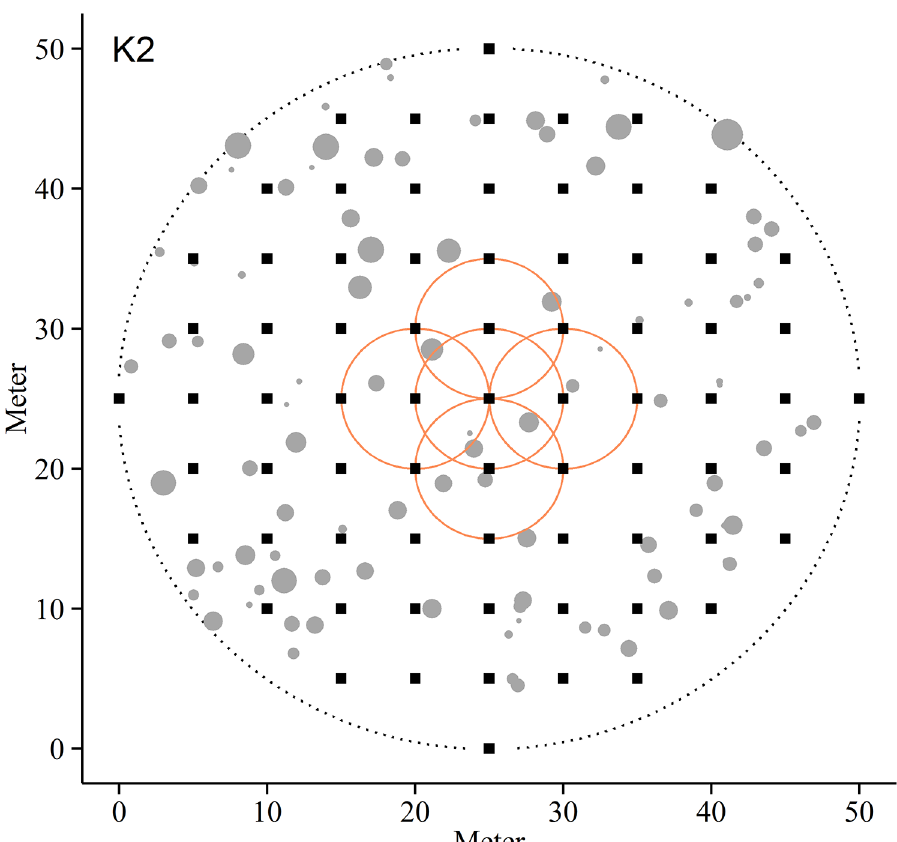
Fig 2. Sampling strategy. Sampling strategy for the eight boreal forest plots used in this study, illustrated by plot K2. Filled squares represent 73 sample points for field layer vegetation, mosses and the organic top soil layer. Filled circles indicate location of standing trees. Stand density measures were calculated at a plot scale (dotted circle) and in subplots with a radius of 5 m around for each of the 73 sampling points (full circles). For illustration purposes only five of the density circles are